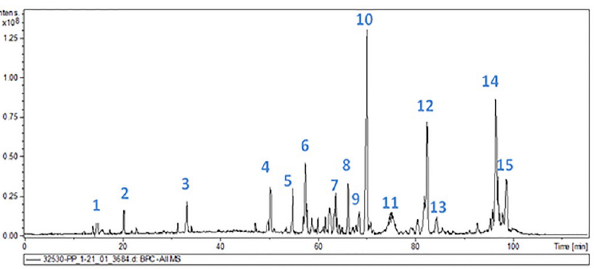
Fig 1. Chromatogram of the hydroalcoholic green propolis extract monitored by absorbance at 270 nm.